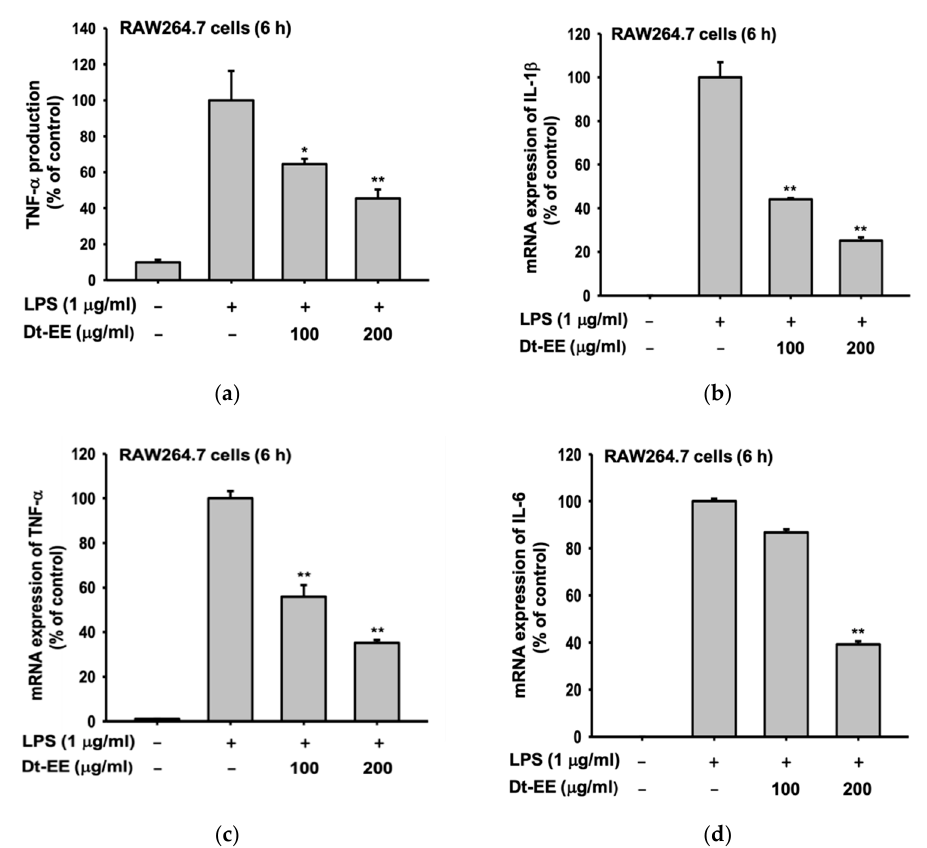
Figure 1. Anti-inflammatory effects of Dt-EE on pro-inflammatory cytokines. ( a ) The production of TNF- α in LPS-induced RAW264.7 cells with and without Dt-EE for 6 h was detected by ELISA. ( b – d ) The mRNA expression levels of pro-inflammatory cytokines, IL-1 β , TNF- α and IL-6, were measured using quantitative real-time PCR. *: p < 0.05 and **: p < 0.01 compared to the induced group.